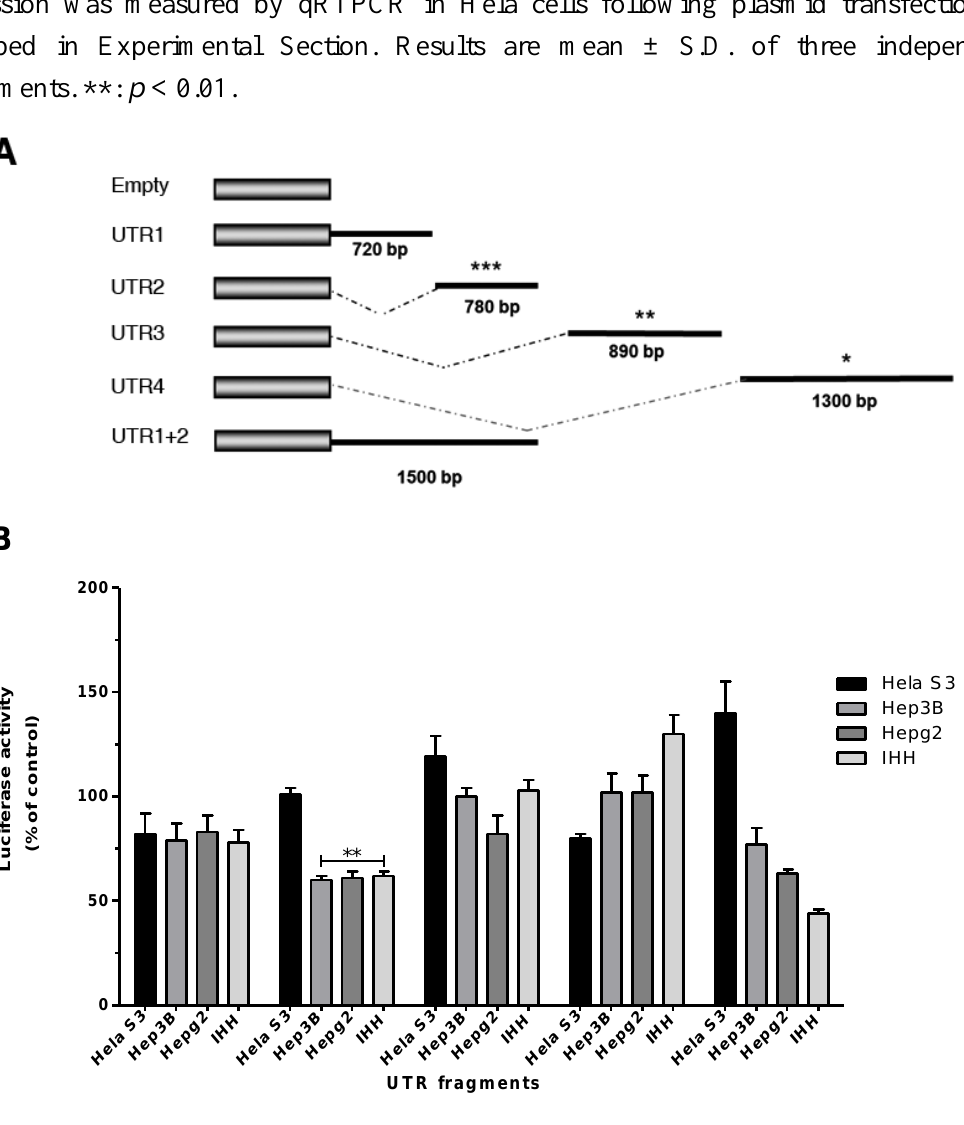
Figure 4. Molecular dissection of KLF6 UTR. ( A ) Representation of the psiCHECK2-derived constructs containing segment 1 (nt 1,114–1,834), 2 (nt 1,835–2,615), 3 (nt 2,616–3,506) or 4 (3,507–4,807) of the KLF6 3'UTR. Segment size is indicated in bold. Hela, IHH, HepG2 and Hep3B cells were transfected for 48 h with plasmid encoding for the indicated KLF6 UTR segments. Control cells were transfected with psiCHECK2 plasmid; ( B